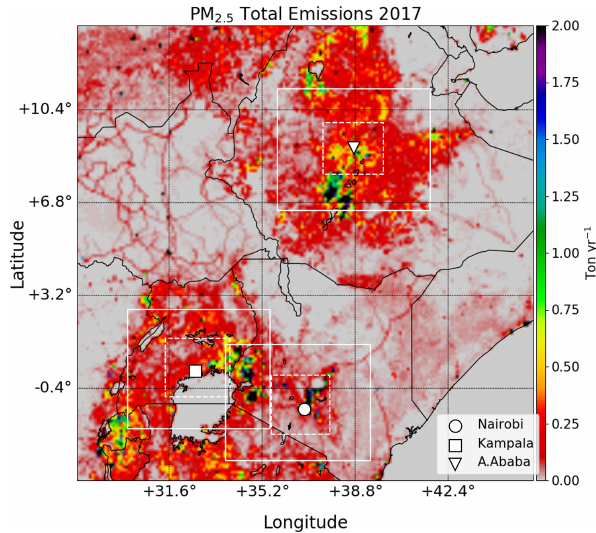
Figure 1. The spatial distribution of the PM 2 . 5 emissions from the DICE–EDGAR merged emission inventory for East Africa for the WRF domain at a 18 × 18km resolution. The continuous white lines show the location of the first nested domain at a 6 × 6km res- olution used in WRF–CHIMERE. The dashed white squares give the locations of the second nested domains at a 2 × 2km resolu- tion centred on Addis Ababa (Ethiopia, white triangle), Kampala (Uganda, white square), and Nairobi (Kenya, white circle) used for